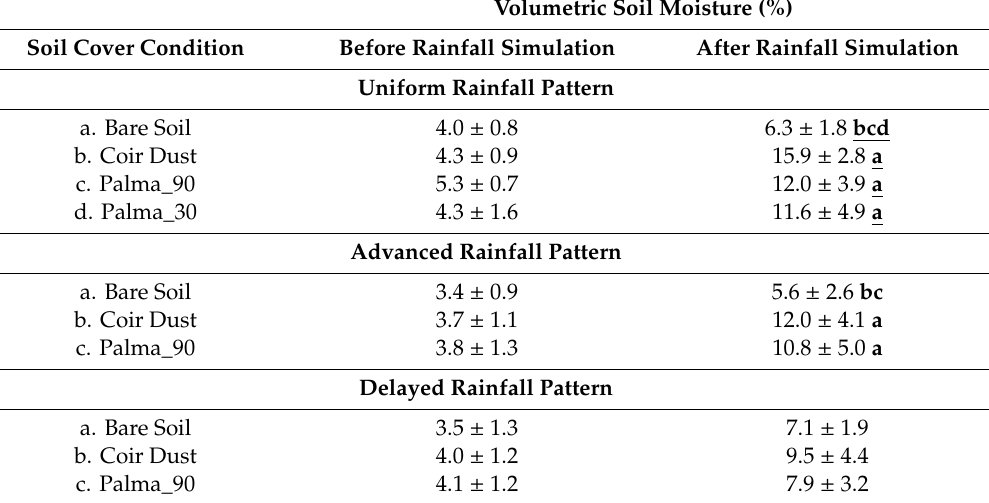
Figure 6. Bar graphs (mean and standard deviation of three repetitions) of volumetric soil moisture before and after rainfall simulation observed for all soil cover conditions and rainfall patterns. Table 2. Mean ± standard deviation (of three repetitions) of volumetric soil moisture before and after rainfall simulation observed for all soil cover conditions and rainfall patterns. Within the same rainfall pattern, values for a soil cover condition followed by letters in bold ( p < 0.05) or bold and underlined ( p < 0.01) are statistically significantly different from the soil cover condition corresponding to that letter.